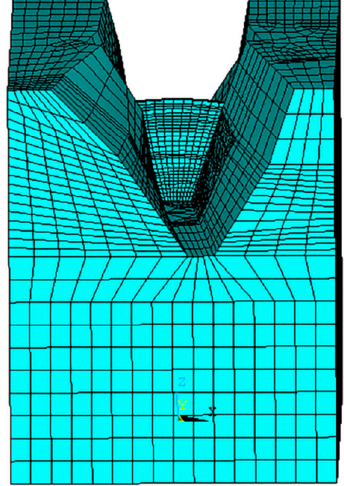
Figure 14: Finite element mesh map of Lizhou arch